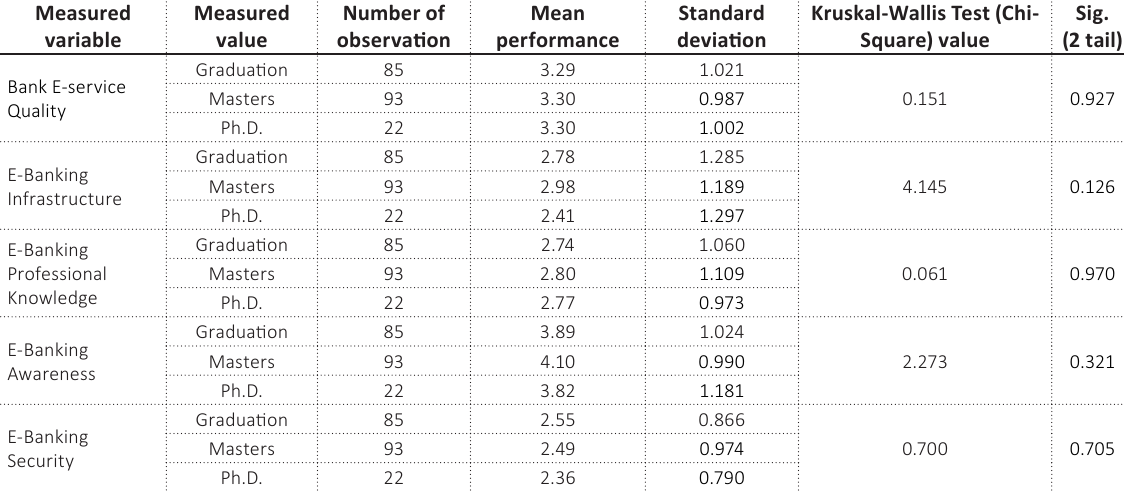
Table 5. Kruskal-Wallis test for education Measured